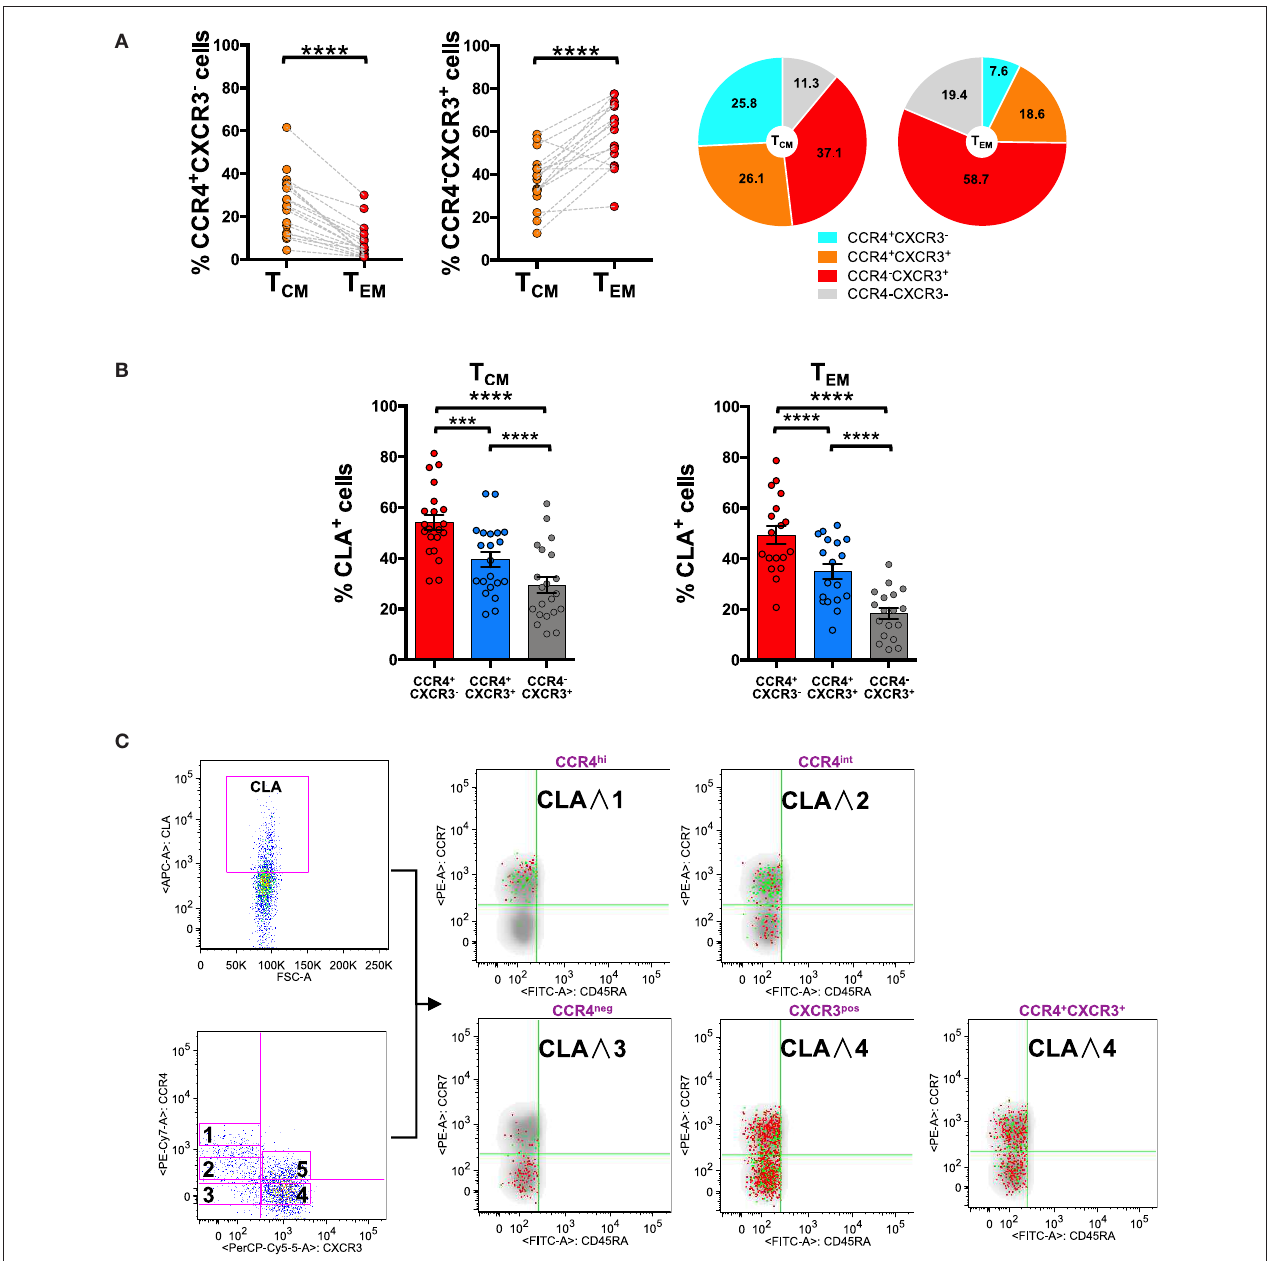
FIGURE 3 | CLA expression is maximal in CCR4 + cells and considerably decreases in CXCR3 + cells. PBMCs isolated from healthy control subjects were stained for CD8, memory T cell phenotype markers (CD45RA and CCR7), for chemokine receptors CCR4, CXCR3, and for CLA. (A) CD8 + T cells gated as T CM and T EM were analyzed for the expression of CCR4 and CXCR3. Statistical analysis of the differences was performed by Mann-Whitney test. p -values < 0.05 were considered significant: *** p < 0.001, **** p < 0.0001. Mean values for CCR4/CXCR3 subpopulations among T CM and T EM cells were shown in pie charts. (B) T CM and T EM cells were analyzed for differences in the percentage of CLA + cells in the CCR4 + CXCR3 − , CCR4 + CXCR3 + , and CXCR3 + subpopulations using Mann-Whitney test. p -values < 0.05 were considered significant: **** p < 0.0001. (C) Reverse analysis is shown in the panel. Total memory CD45RA − CD8 + T cells were gated and analyzed for the expression of CLA and for chemokine receptors CCR4/CXCR3. On the basis of the chemokine receptor expression we identified five subsets CCR4 hi (gate 1), CCR4 int (gate 2), CCR4 − CXCR3 − (gate 3), CCR4 − CXCR3 + (gate 4), CCR4 + CXCR3 + (gate 5). The five subsets of CCR4/CXCR3 expressing cells were overlaid to the density plot of CD45RA − cells. Each red dot represents a cell from the corresponding subset. Among those dots, green dots identify cells of the gated subsets (CCR4 hi , CCR4 int , CCR4 − CXCR3 − , CCR4 − CXCR3 + , and CCR4 + CXCR3 + ) that co-express CLA. The axis scales for fluorescence are reported as log.